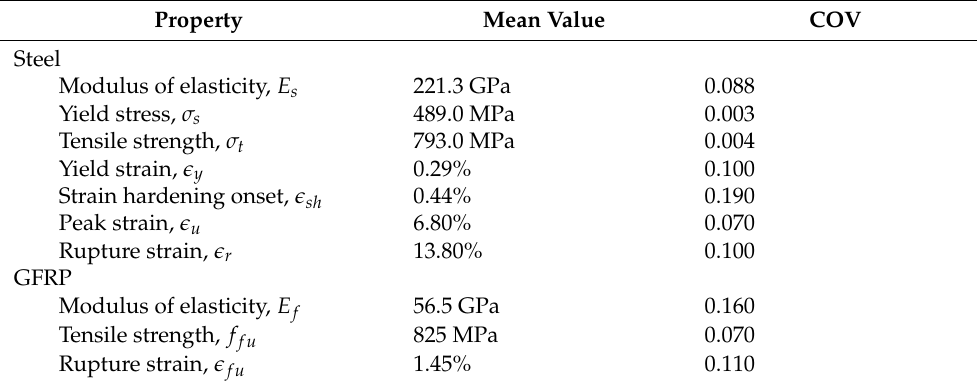
Table 5. Steel and GFRP reinforcement properties, note four total bars tested for each